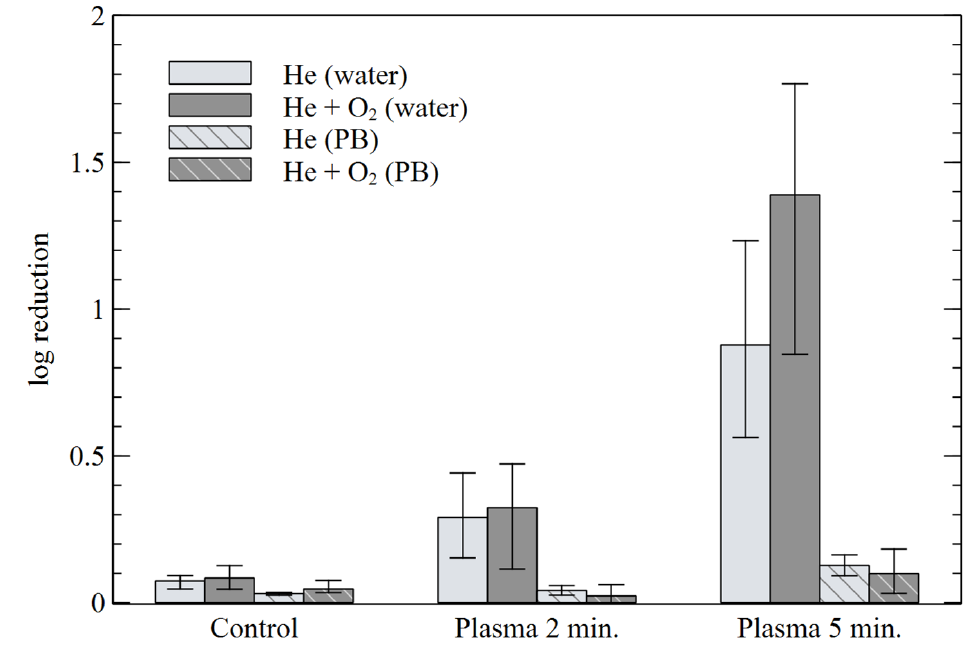
Figure 11. Logarithmic reduction of E. coli in aqueous water and PB solutions for different treatment times.